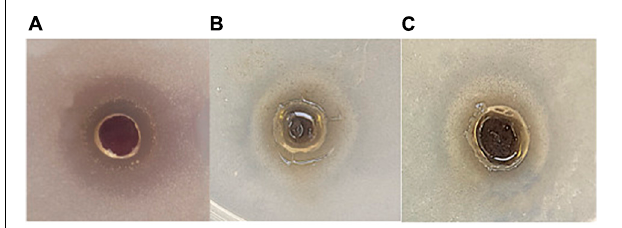
FIGURE 3 | Antimicrobial effect of H. werneckii AS1 melanin using agar diffusion method on (A) Aeromonas sp., (B) Staphylococcus aureus , and (C) Enterococcus faecalis .